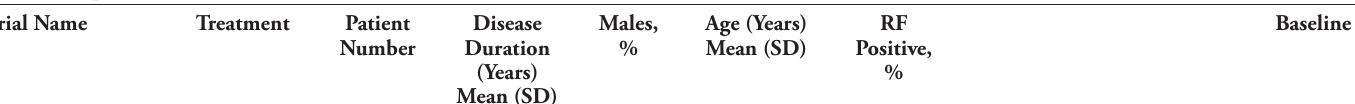
Table 1. Population characteristics: MTX-IR,